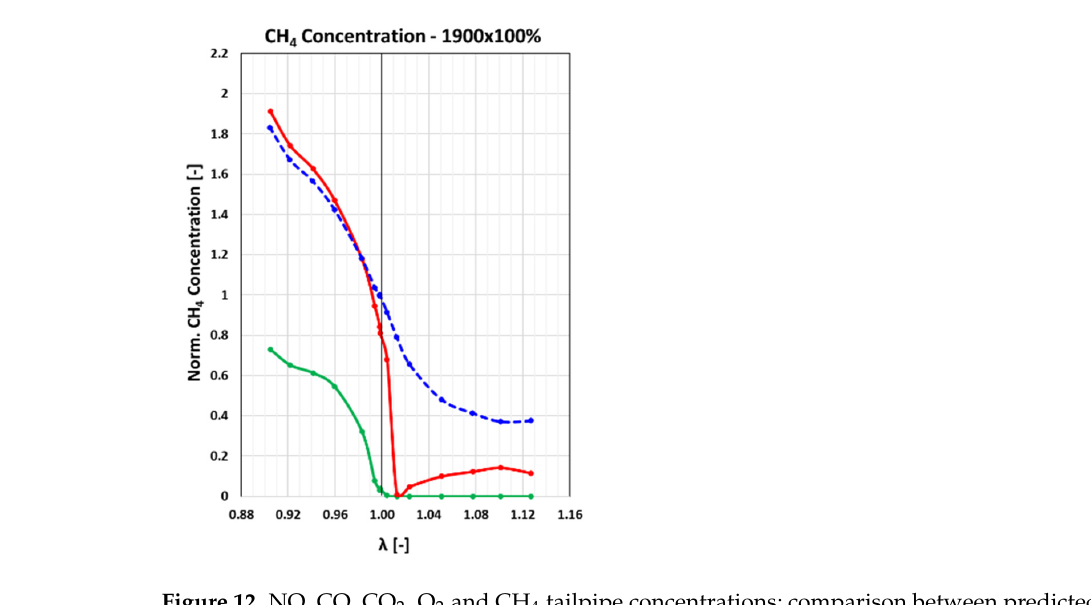
Figure 12. NO, CO, CO 2 , O 2 and CH 4 tailpipe concentrations; comparison between predicted and experimental data during λ variations.